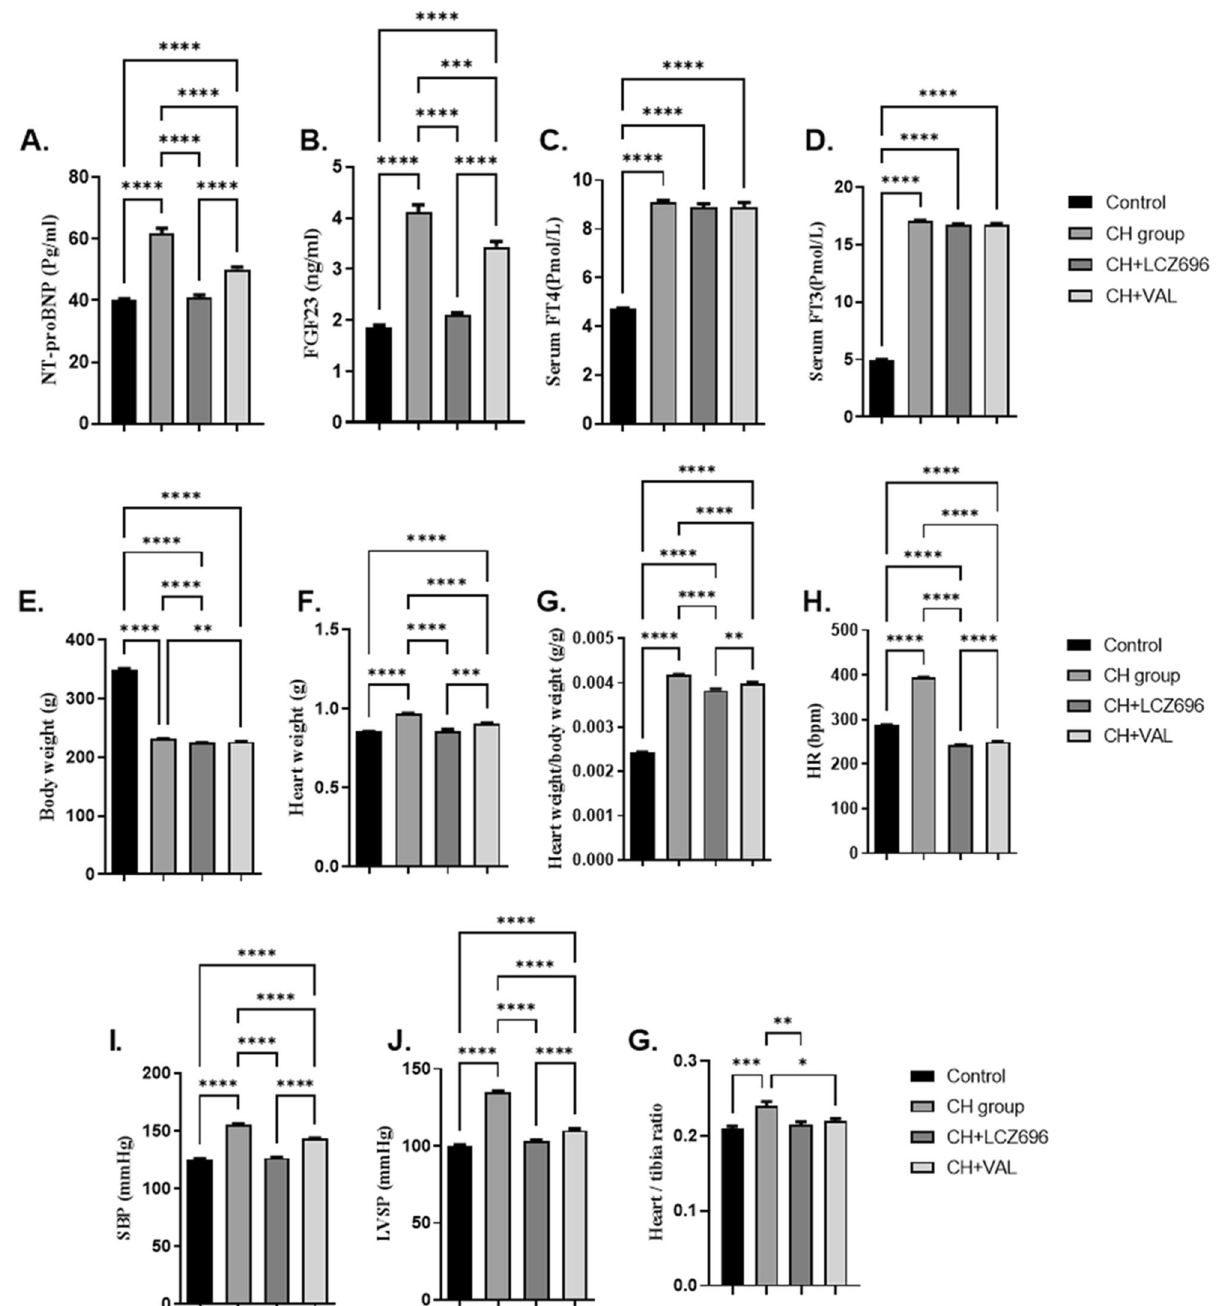
Figure 1. The effect of the LCZ696 and VAL administration on the hemodynamic parameters, cardiac hypertrophy markers, serum thyroid hormonal level ( A – J ). ( A ) serum NT-proBNP level (Pg/mL). ( B ) serum FGF23 level (ng/mL), ( C ) serum FT4 level (Pmol/L), ( D ) serumFT3 level (Pmol/L), ( E ) body weight (g), ( F ) heart weight (g), ( G ) heart/body weight ratio, ( H ) heart rate (HR) bpm, ( I ) systolic blood pressure (SBP) mmHg, ( J ) left ventricular systolic pressure (LVSP) mmHg, and ( K ) heart weight/tibia ratio. Values are mean of 6 rats per group ± S.E.M * p < 0.05; ** p < 0.01; *** p < 0.001. Group means were compared by one-way analysis of variance (ANOVA) followed by Tukey post hoc tests for multiple